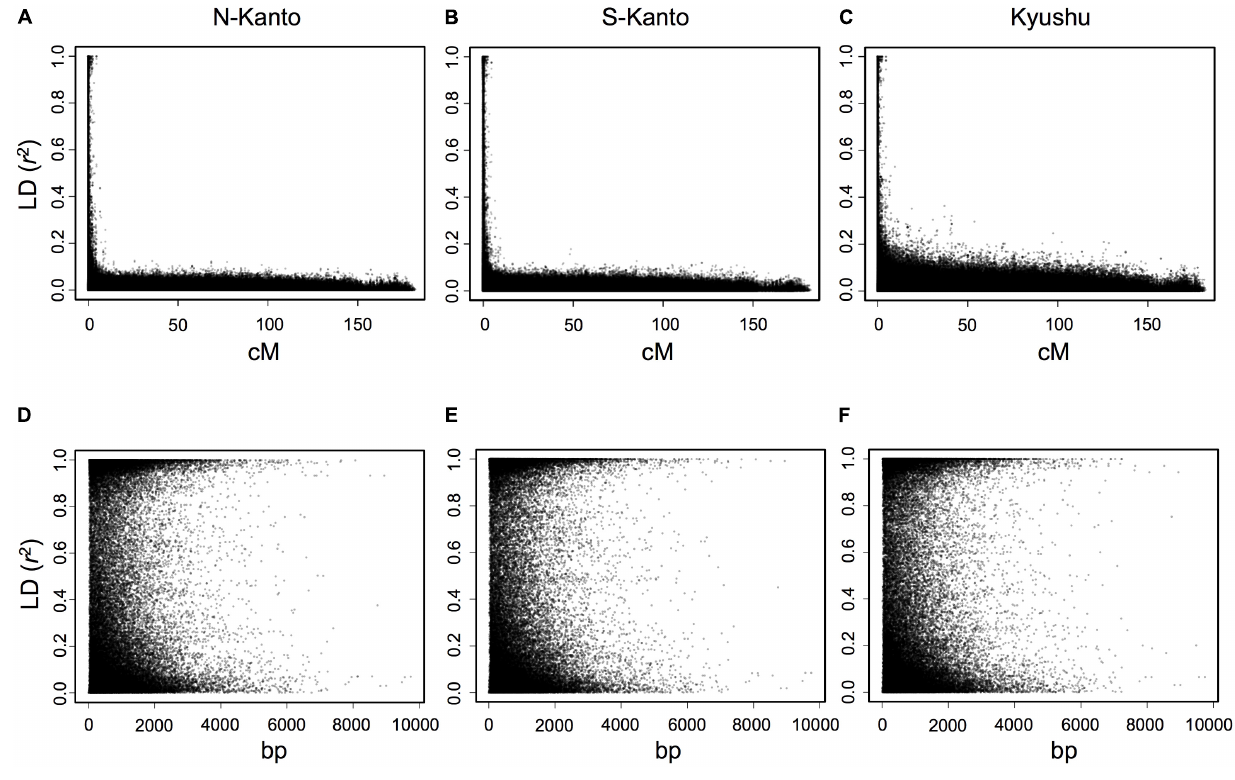
FIGURE 1 | Linkage disequilibrium ( r 2 ) versus map distance (cM) for each population of C. japonica plus trees. Upper and lower panels represent LDs within the same LG and within the same isotigs for populations N-Kanto ( A and D , respectively), S-Kanto ( B and E , respectively) and Kyushu ( C and F , respectively). Data derived from the 11 LGs were represented together for each